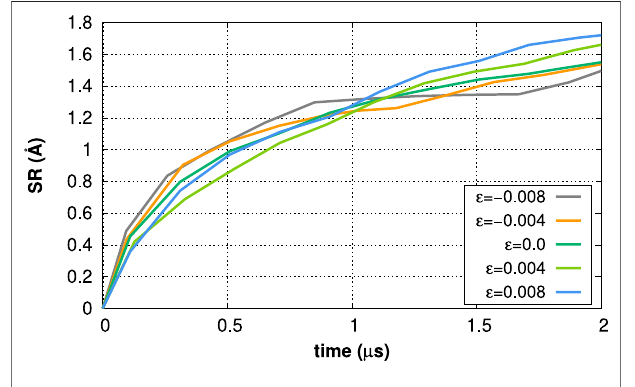
FIGURE 4 | Surface roughness evolution at various levels of applied equibiaxial strain.